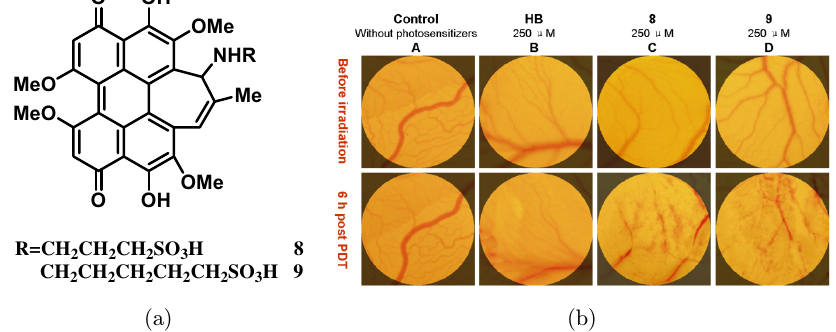
Fig. 6. (a) The molecular structures of 8 and 9 . (b) PDT e®ects of HB (B), 8 (C) or 9 (D) on the blood vessels of CAM along with that of without photosensitizer as a control (A). First or second line is the blood vessels images of CAM recorded before irradiation or 6 h after